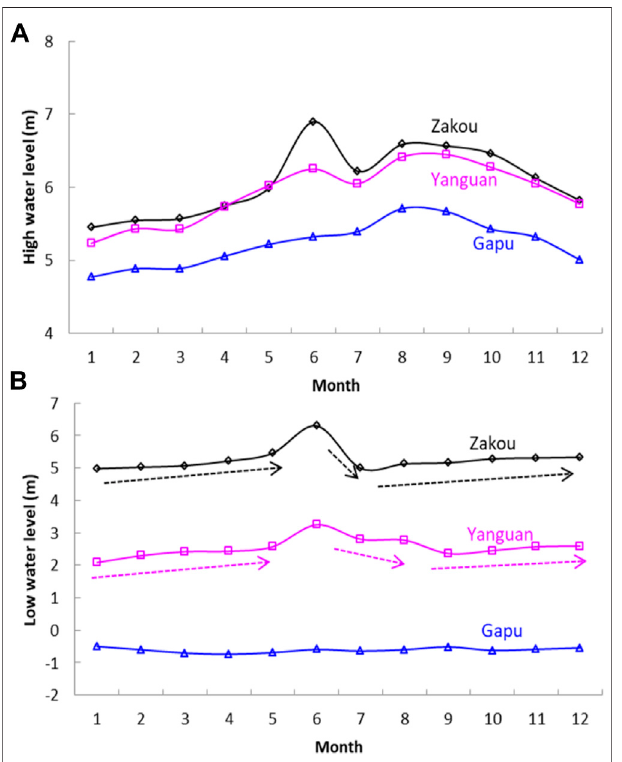
FIGURE6| Monthlyaveragedhigh (A) andlow (B) waterlevelsatZakou, Yanguan and Ganpu Station in 2015.